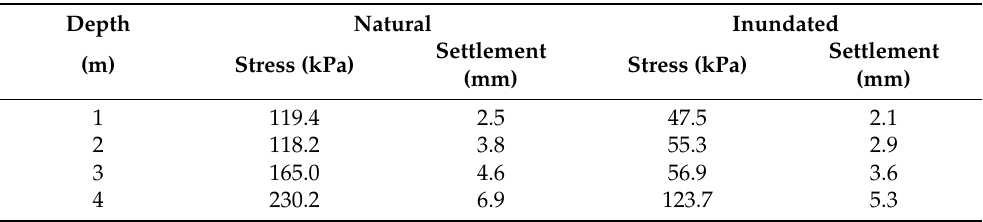
Figure 12. Settlements estimated from DMT vs. those obtained by PLT for the natural ( a ) and inundated ( b ) conditions of the study site. Table 4. Measured settlement from PLT in working conditions.